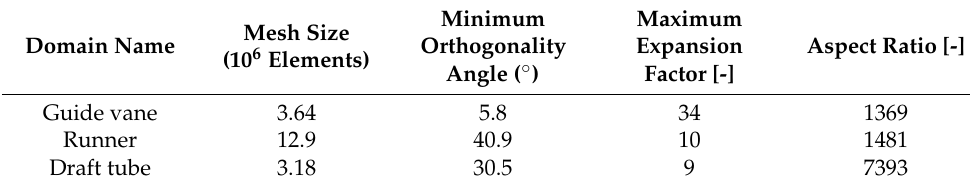
Table 2. Mesh size and quality parameters of the mesh used in the